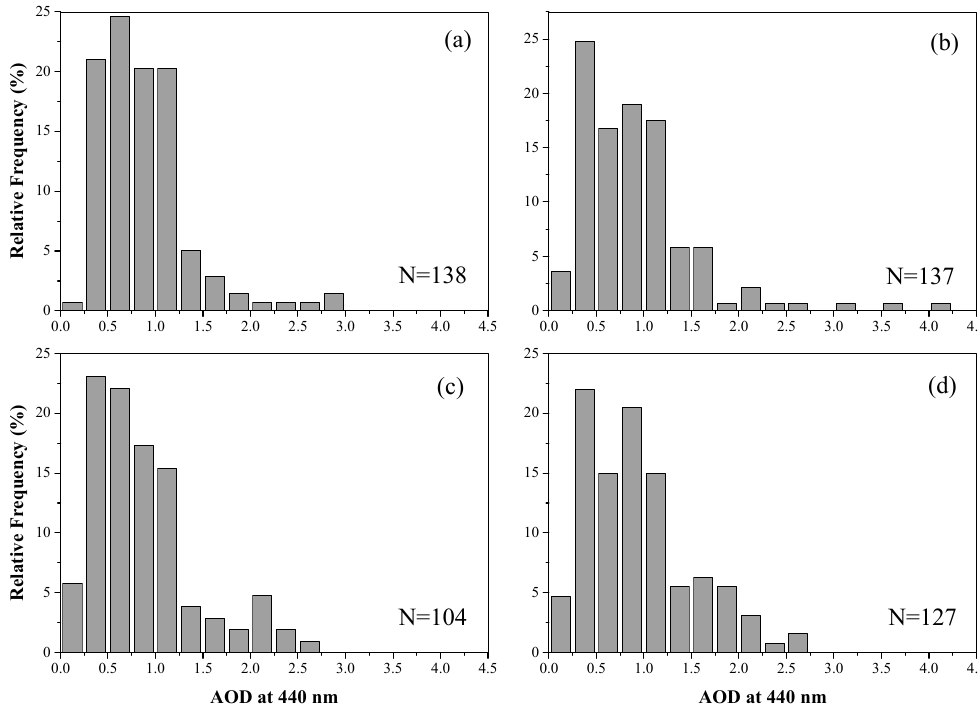
Figure A1. Frequency distributions of AOD at 440 nm for ( a ) spring, ( b ) summer, ( c ) autumn and ( d ) winter in Xi’an site.